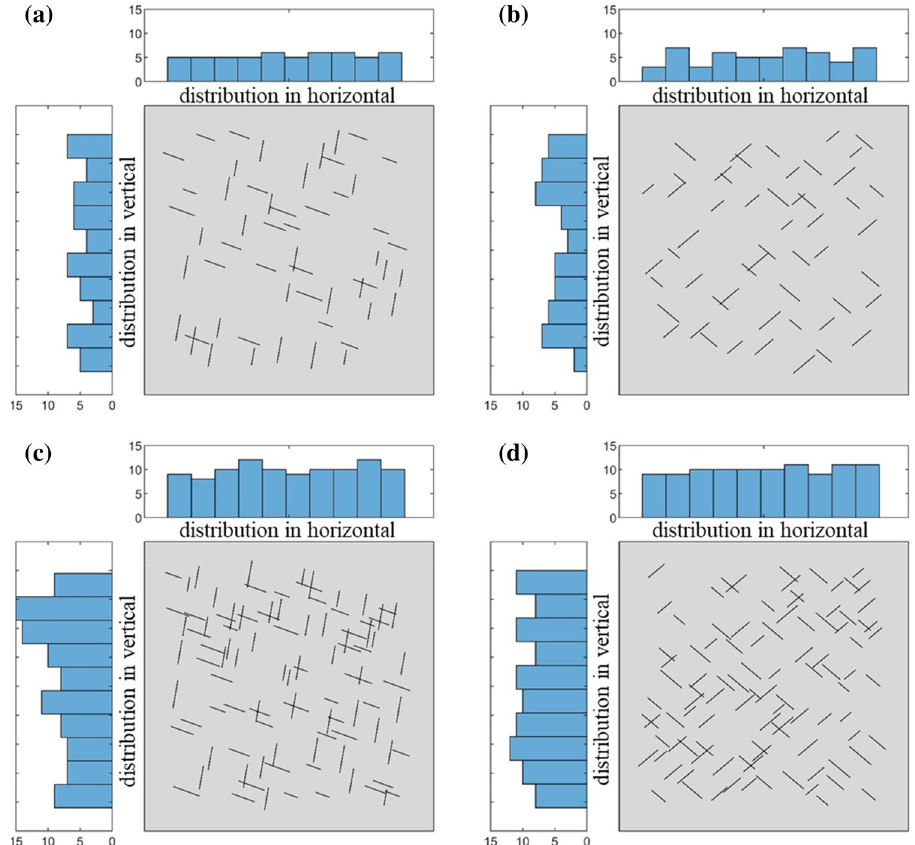
Fig. 3 Four groups natural crack with various trend and density. Group ( a ) contains 54 cracks with a angle of − 20°and 80°from horizontal. Group ( b ) contains 54 cracks with an angle of ± 40°from horizontal. Group ( c ) contains 100 cracks with an angle of − 20°and 80°from horizontal. Group ( d ) con- tains 100 cracks with an angle of ± 40°from